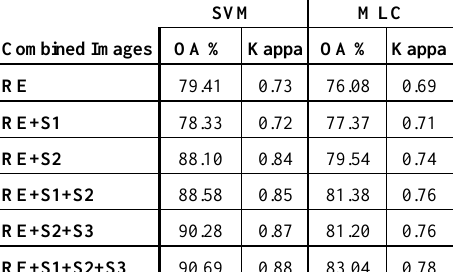
Figure 3. Producer´s and user´s accuracies for winter barley for all image combinations